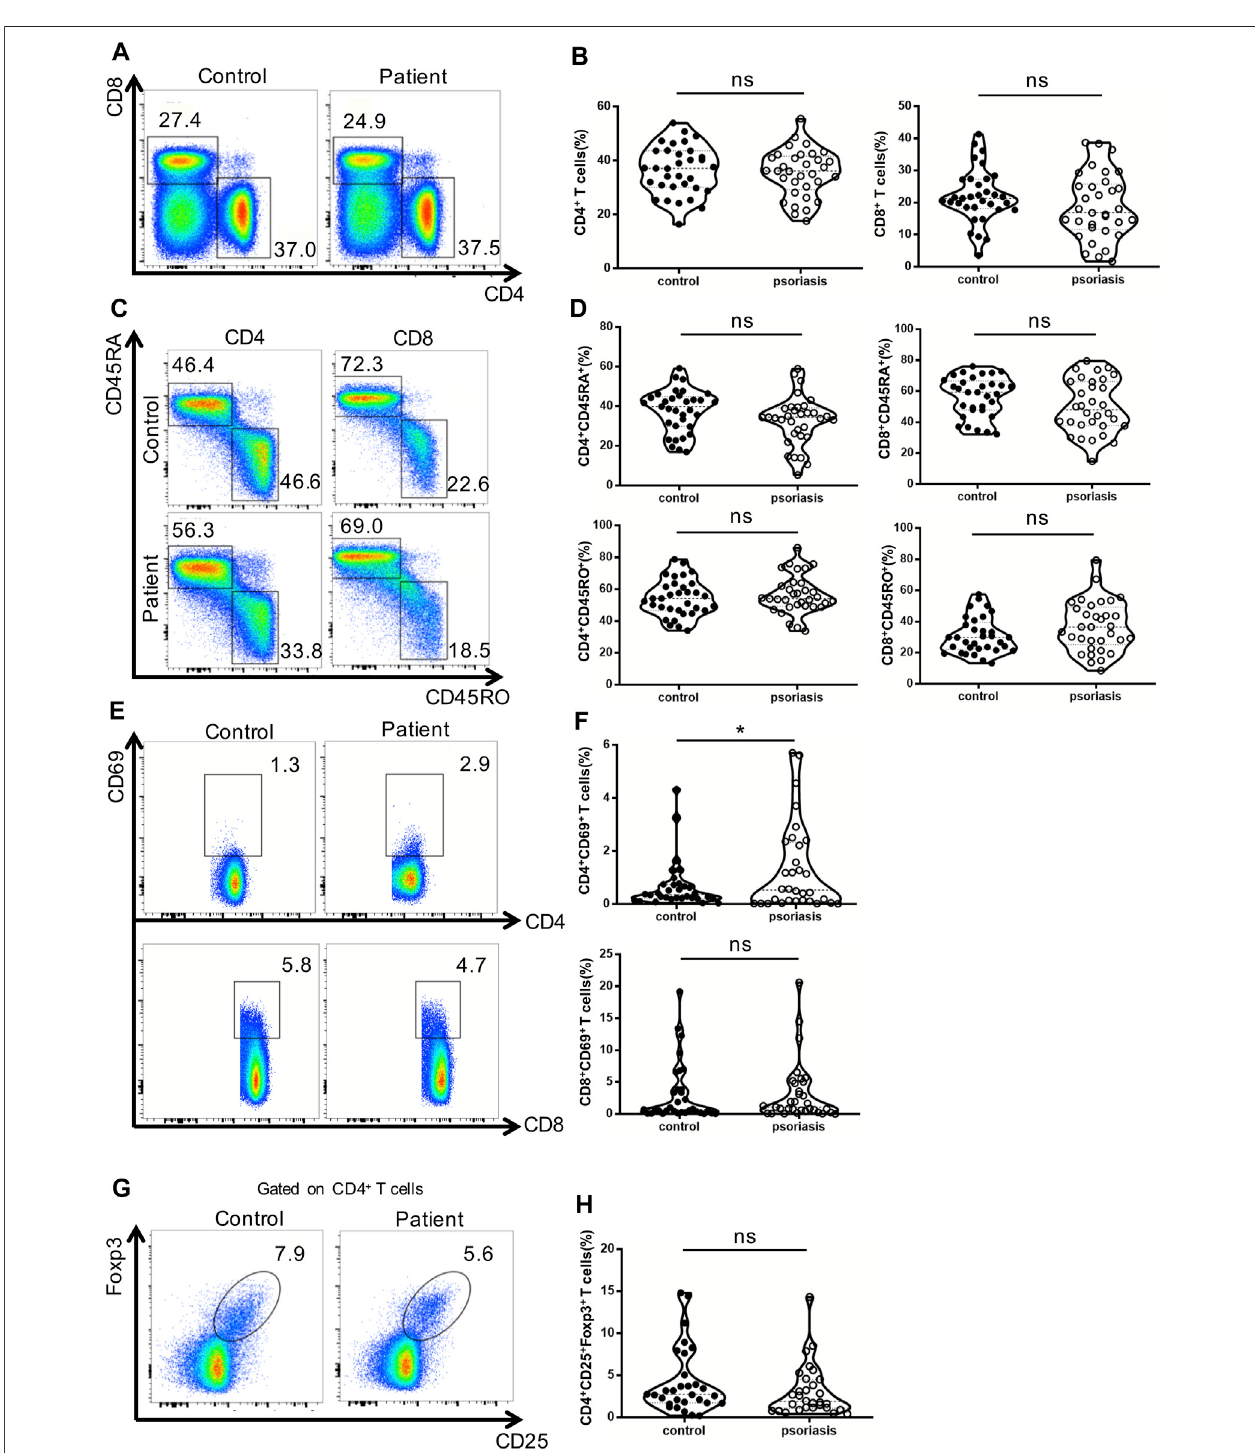
FIGURE 1 | Distribution of conventional T cells and Tregs in the peripheral blood. (A) Flow cytometry analysis of CD4 + and CD8 + T cells in PBMCsfrom moderate- to-severeplaque psoriasispatientsandhealthycontrols. (B) SummaryplotsshowingindividualresultsofthefrequencyofCD4 + andCD8 + Tcellsinmoderate-to-severe plaque psoriasis patients versus healthy controls. (C) Flow cytometry analysis of memory (CD45RO+) and naïve (CD45RA+) CD4 + and CD8 + T cells in PBMCs from moderate-to-severe plaque psoriasis patients and healthy controls. (D) Summary plots showing individual results of the frequency of CD45RA+ and CD45RO + CD4 + and CD8 + T cells in moderate-to-severe plaque psoriasis patients versus healthy controls. (E) Flow cytometry analysis of CD69 expression in CD4 + and CD8 + TcellsinPBMCsfrommoderate-to-severeplaquepsoriasispatientsandhealthycontrols. (F) SummaryplotsshowingindividualresultsofthefrequencyofCD69 + CD4 +